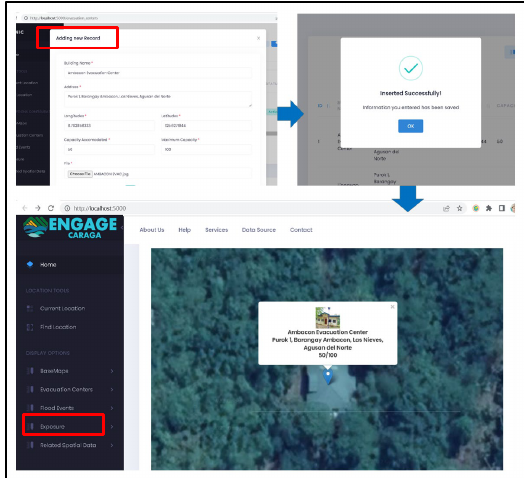
Figure 10. Operations of Evacuation Centers under Display Options Figure 12. Operations to Provide Real-time Spatial Information